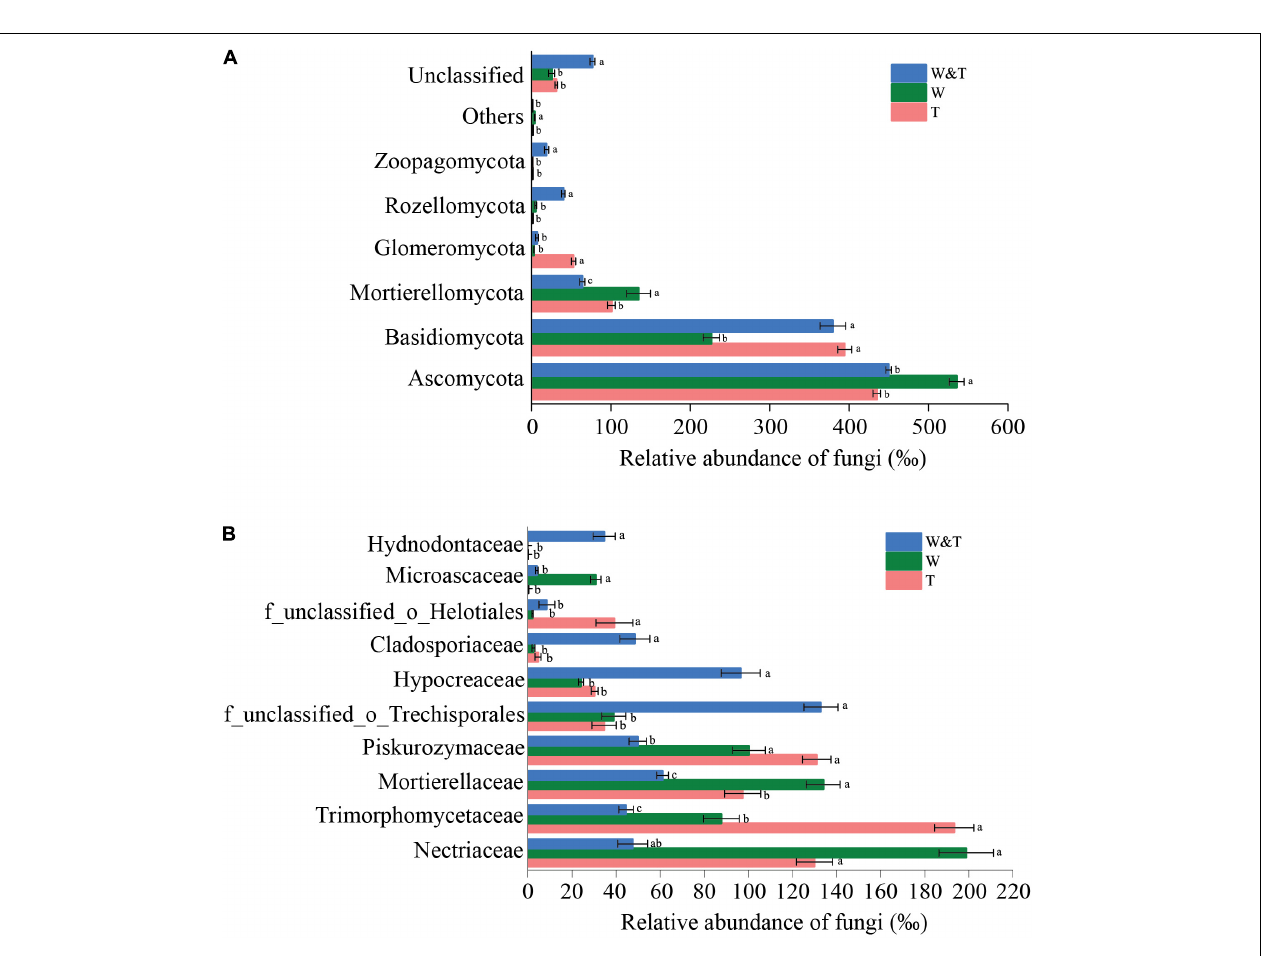
Frontiers in Microbiology |